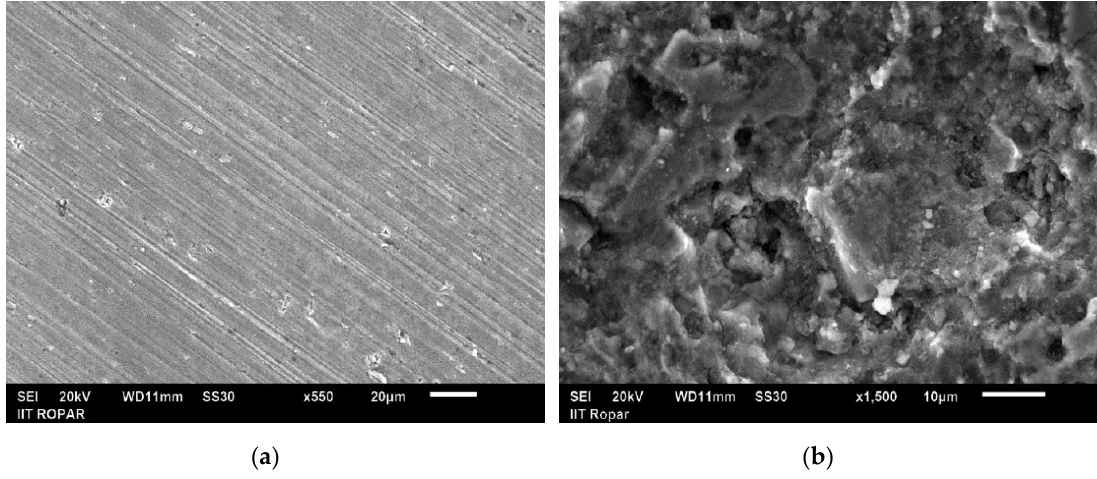
Figure 5. SEM showing; ( a ) substrate or untreated sample, and ( b ) surface treated in MWCNTs mixed